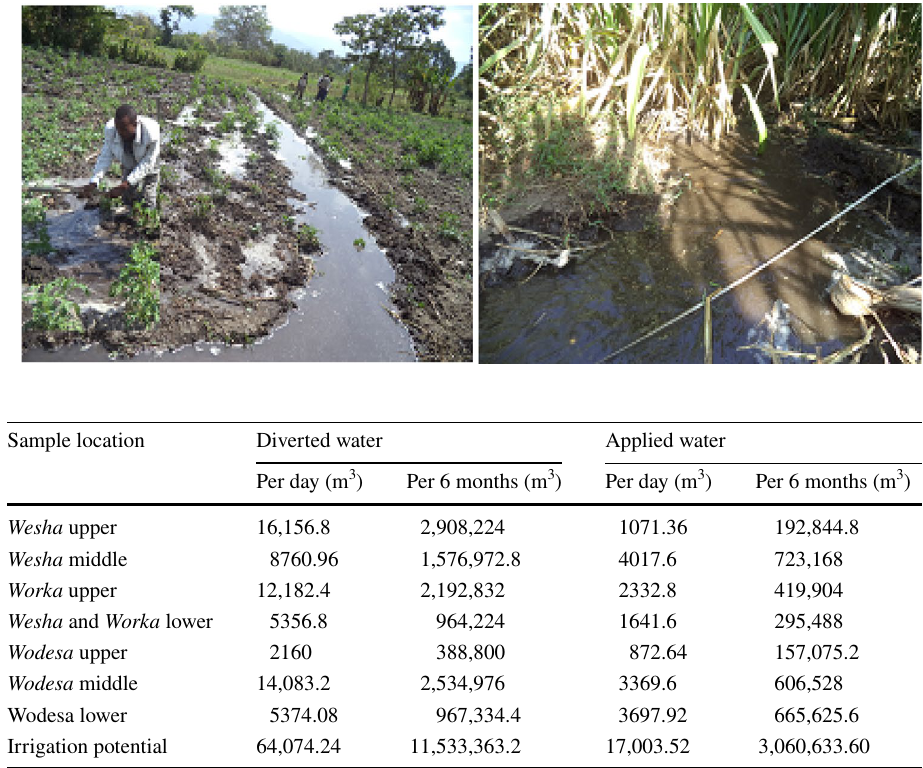
F fruit (avocado), S sugarcane, P potato,